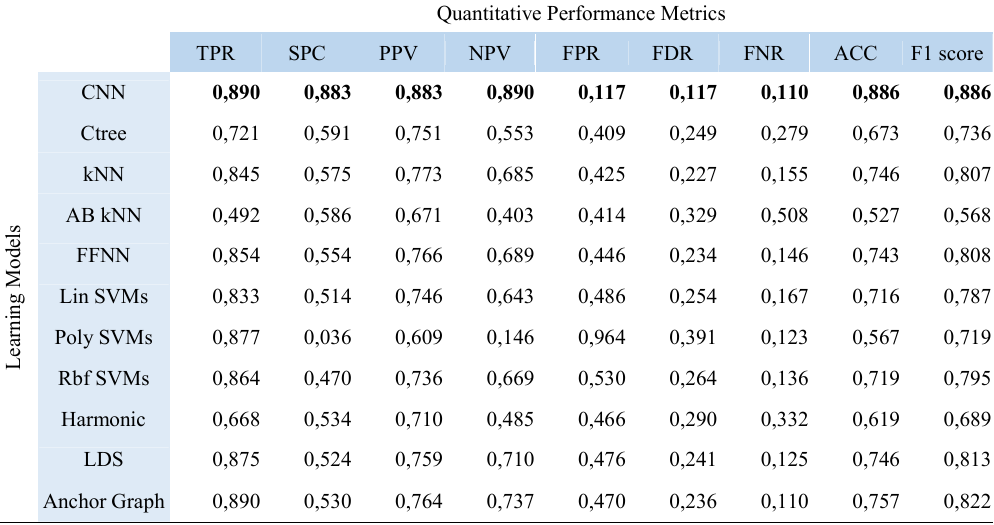
Table 2: Image analysis for one indicative image taken under different radiometric